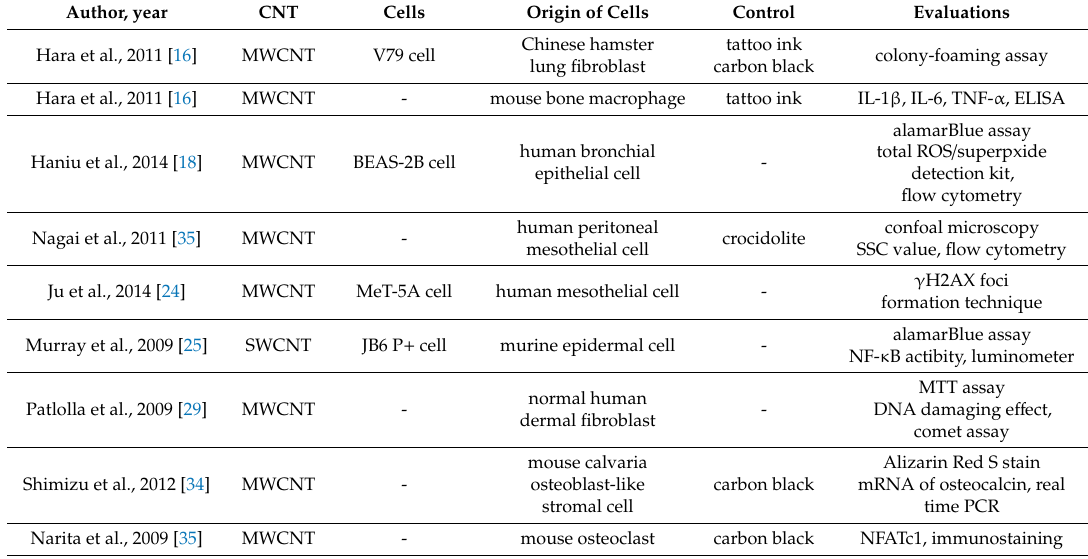
Table 1. In vitro biocompatibility testing of